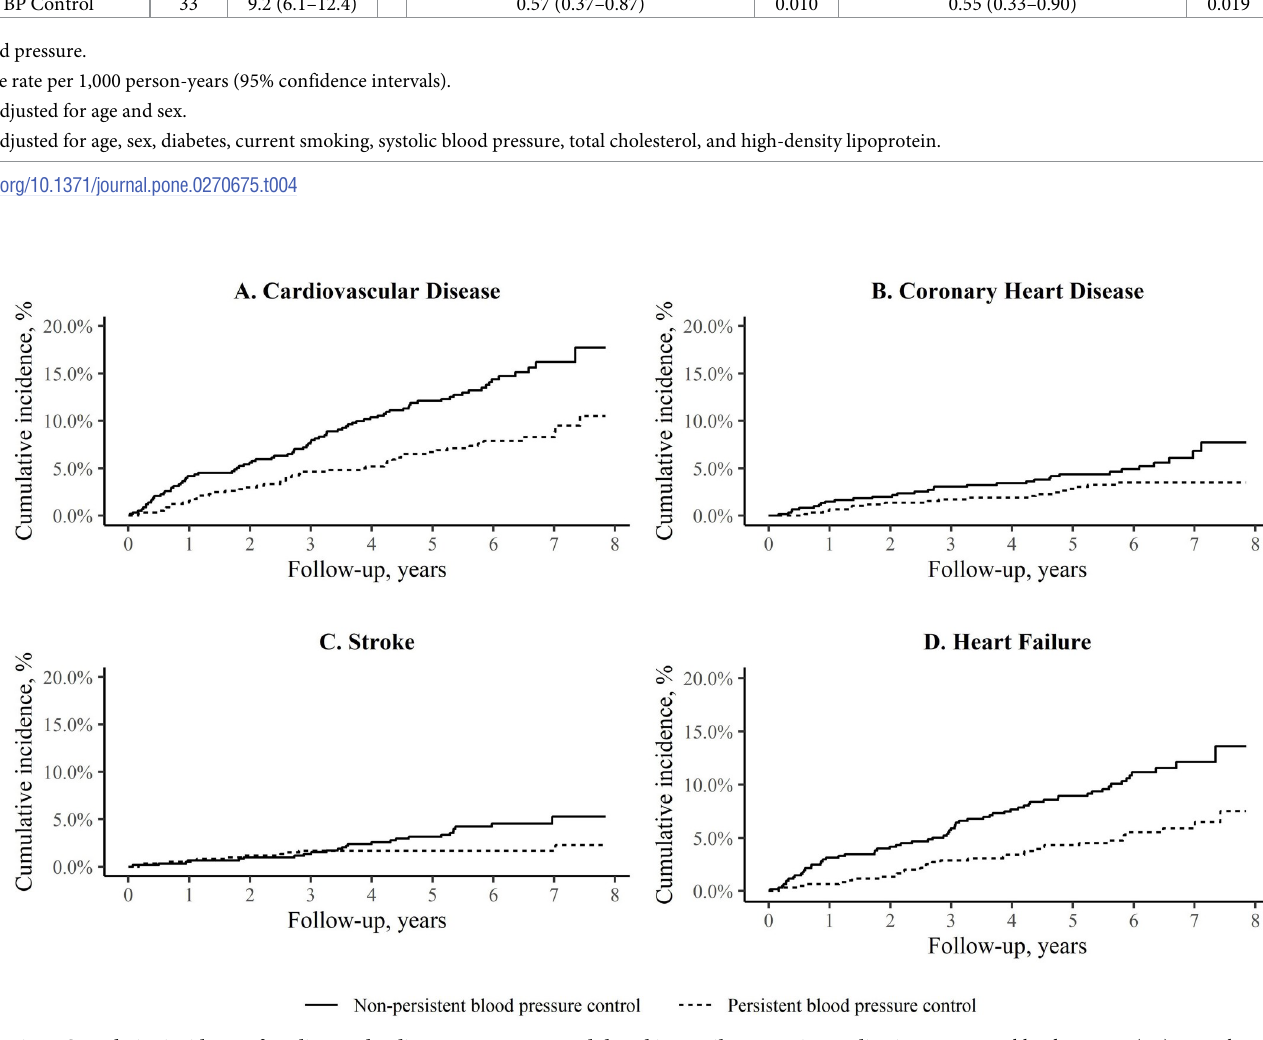
Fig 1. Cumulative incidence of cardiovascular disease events among adults taking antihypertensive medication. Persistent blood pressure (BP) control was defined as having controlled BP (systolic BP < 140 mm Hg and diastolic BP < 90 mm Hg) across three Jackson Heart Study visits (Visit 1 from 2000–2004, Visit 2 from 2005–2008, and Visit 3 from 2009–2013). Cardiovascular disease was a composite of coronary heart disease, stroke, and heart failure.